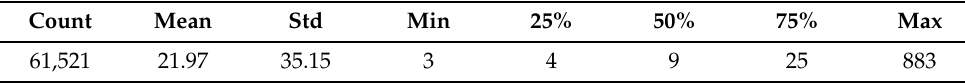
Table 3. Statistics of POI number dataset.